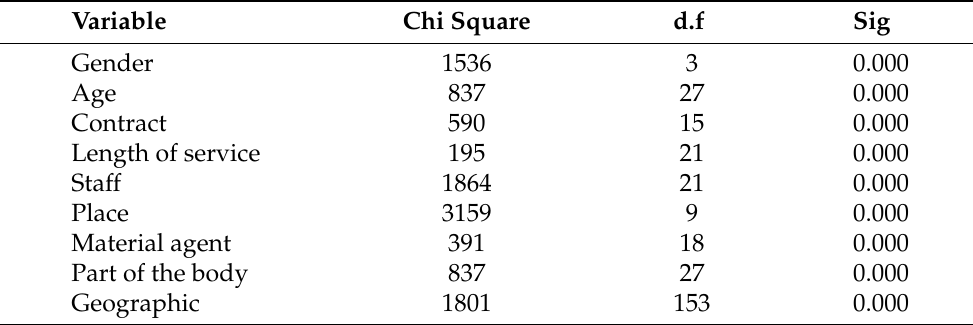
Table 2. Selection of variables analyzed according to their statistical